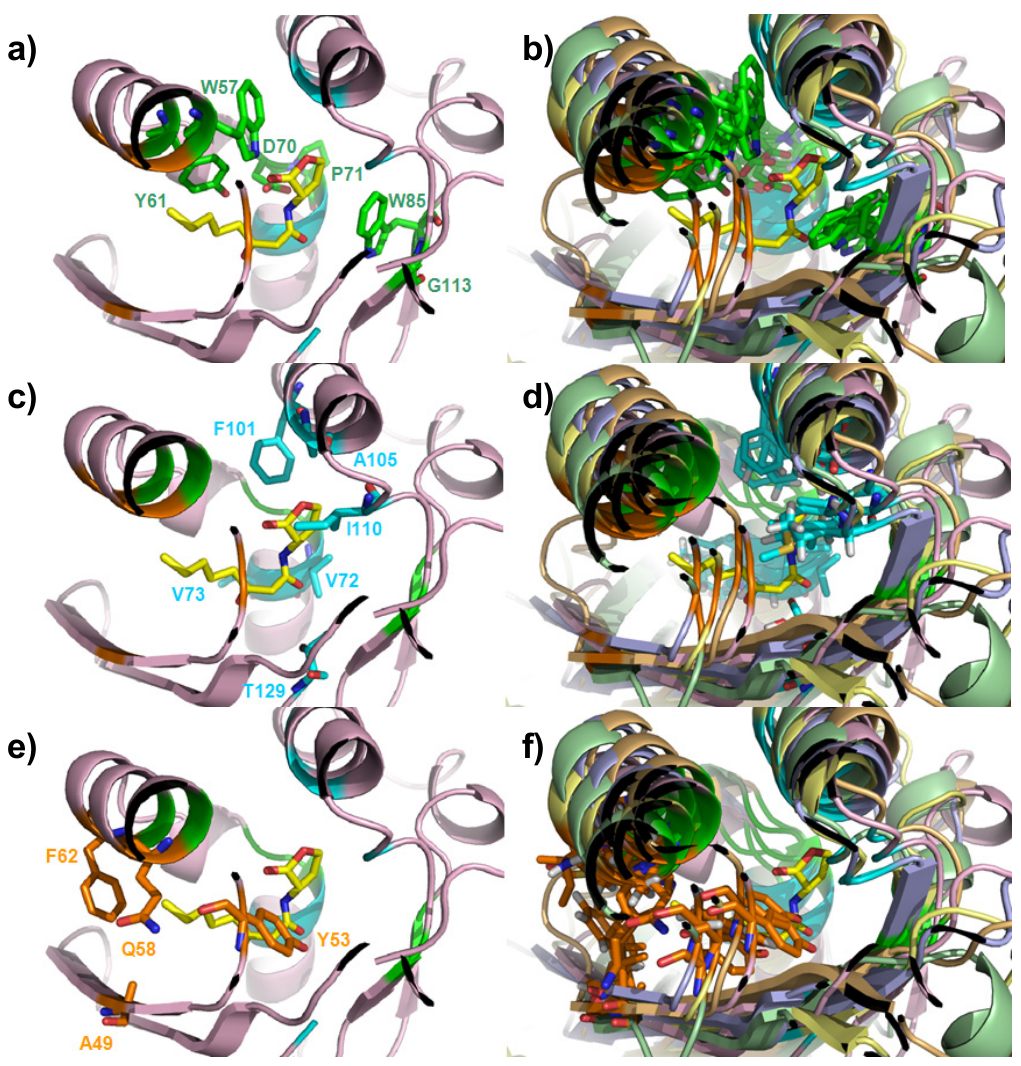
Figure 2. Mapping of the identified Clusters residues on the regulatory domains of the QS LuxRs. Residues, belonging to Cluster 1 (in green), Cluster 2 (in cyan) and Cluster 3 (in orange) and labeled according to the TraR numbering scheme, have been mapped in ( a ), ( c ) and ( e ) on the X-ray crystal structure of TraR in complex with OC8-HSL (PDB_ID 1H0M [24]); in ( b ), ( d ) and ( f ) on the superimposed C traces of the representative α structures of the regulatory domains of QS LuxR, showing the side chains orientations, with TraR (PDB_ID 1H0M [24]) in light pink, LasR (PDB_ID 3IX3) in light orange, QscR (PDB_ID 3SZT [28]) in light yellow; SdiA (PDB_ID 2AVX [30]) in light blue, CviR (PDB_ID 3QP1 [29]) in light green. The carbon, nitrogen and oxygen atoms of OC8-HSL, are colored in yellow, blue and red respectively. Figures produced by Pymol